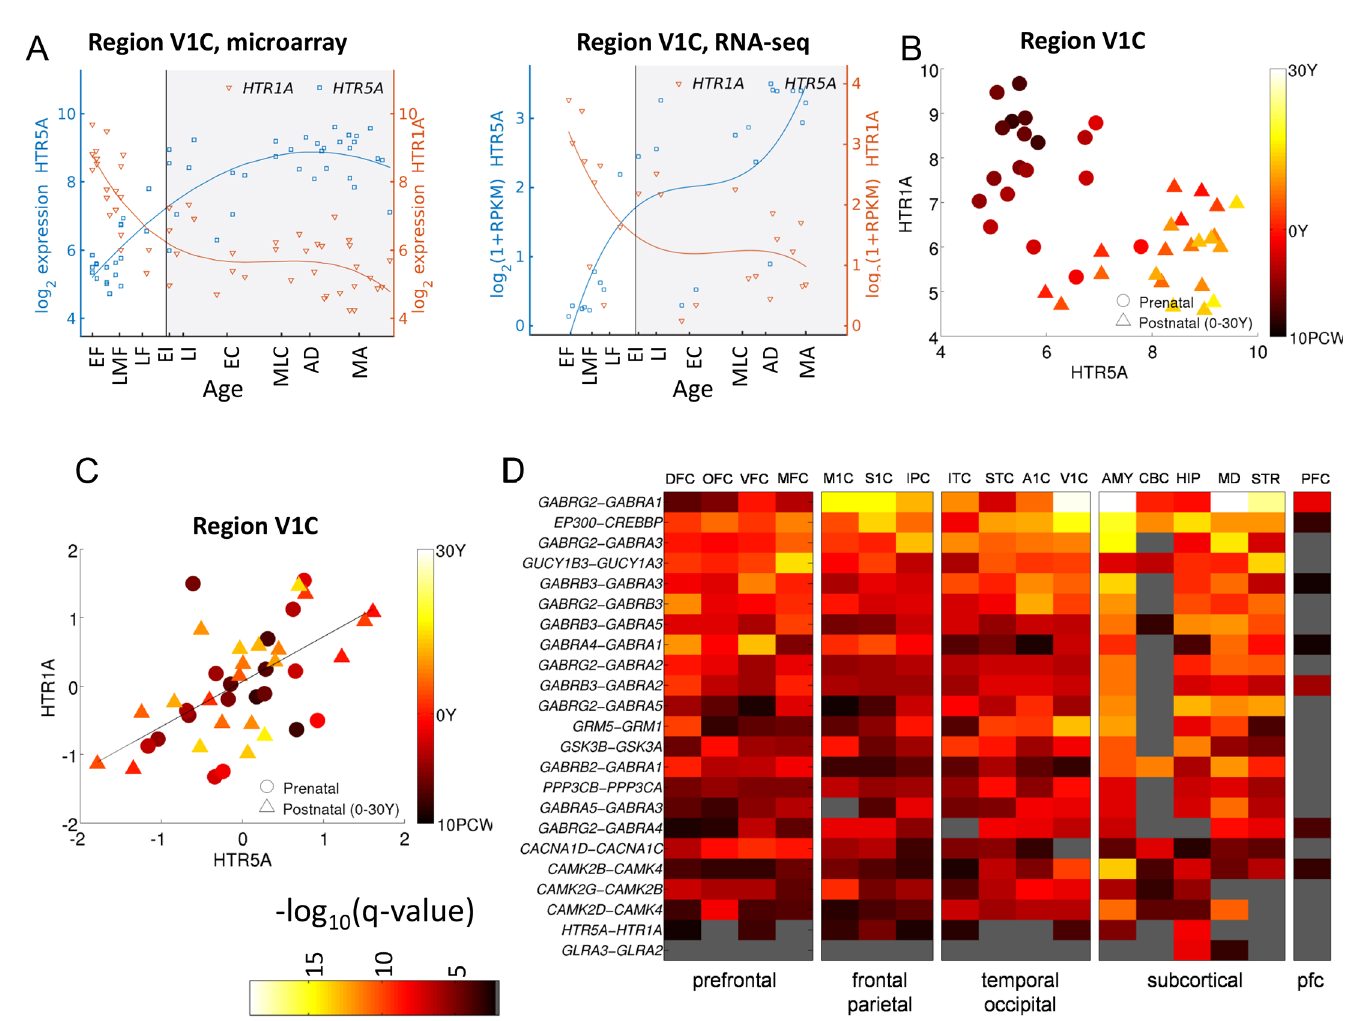
Fig 3. Age-corrected correlation. (A) An example of fitting a cubic spline[80] to the expression of HTR1A and HTR5A in the primary visual cortex (V1C). Circles denote measured data points and solid lines denote a cubic spline fit. (B) Expression levels of HTR1A and HTR5A . Circles denote the expression of prenatal subjects, triangles of postnatal. The color scale denotes the age of each donor, with older subjects in light yellow and young subjects in dark. The expression is anti-correlated ( ρ = -0.58). (C) After removing the population effect of age, the expression of HTR1A and HTR5A is positively correlated across subjects ( ρ = 0.53, q -value < 10 − 4 , Pearson). (D) The magnitude of age-corrected correlation (residuals) of 20 CDV pairs, ranked by the mean correlation over